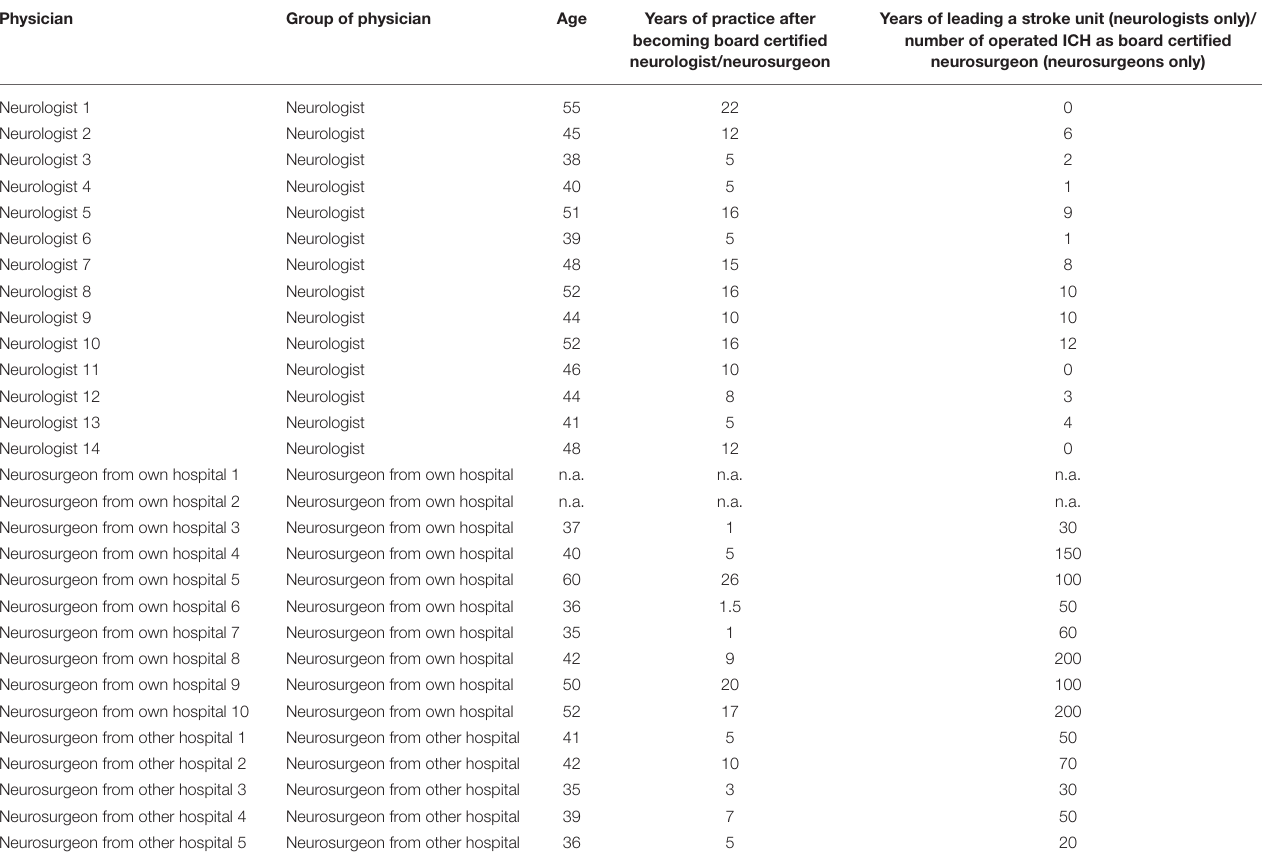
TABLE 2 | Age and years of experience of board-certified neurologists and neurosurgeons-raw data. Physician